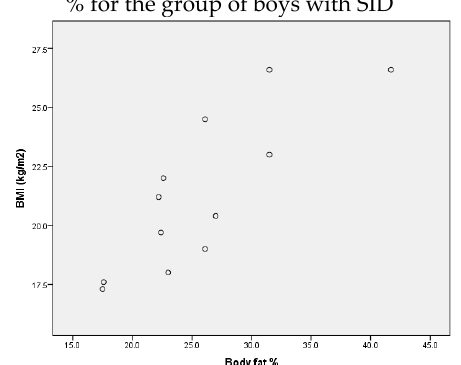
Graph 2. Correlation between BMI and muscle mass % for the group of boys with SID